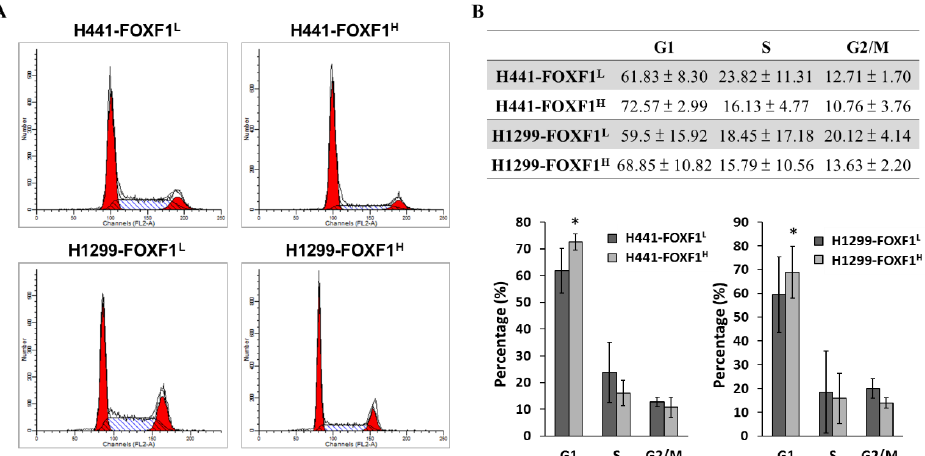
Figure 3. Effect of high expression of FOXF1 on cell cycle of non-small-cell lung cancer cell lines. ( A ) Representative histograms of flow cytometric analysis of cell cycle, and ( B ) quantification of cells (%) at the gap 1 (G1), synthesis (S), and gap 2 (G2)/mitosis (M) phase of H441-FOXF1 H and H1299-FOXF1 H cell lines compared to their respective controls. Data are expressed as means ± SE. * p < 0.05, using Welch’s unpaired t-test .